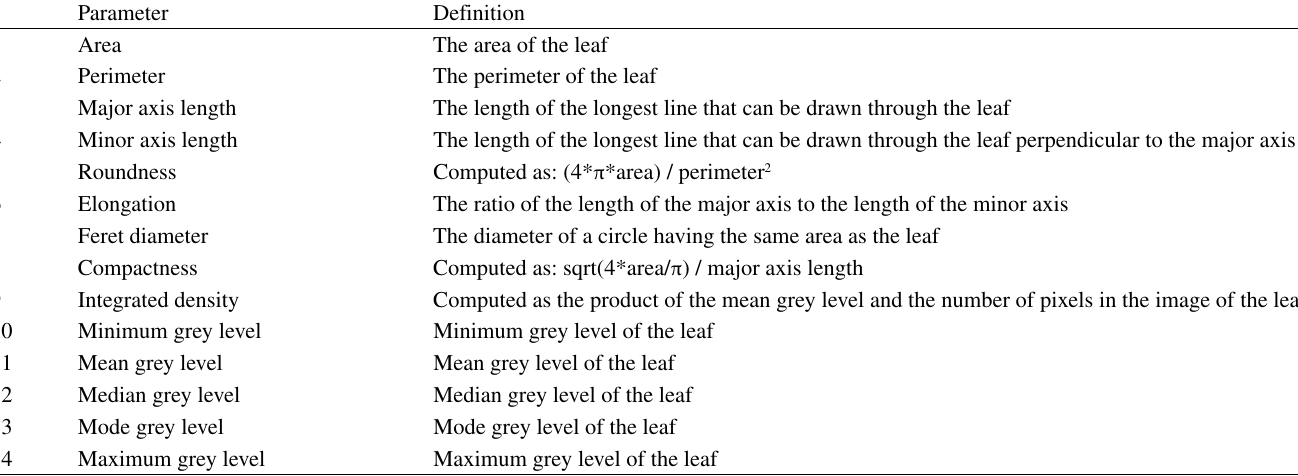
Table 3 - Fourteen phyllometric parameters measured by image analysis software